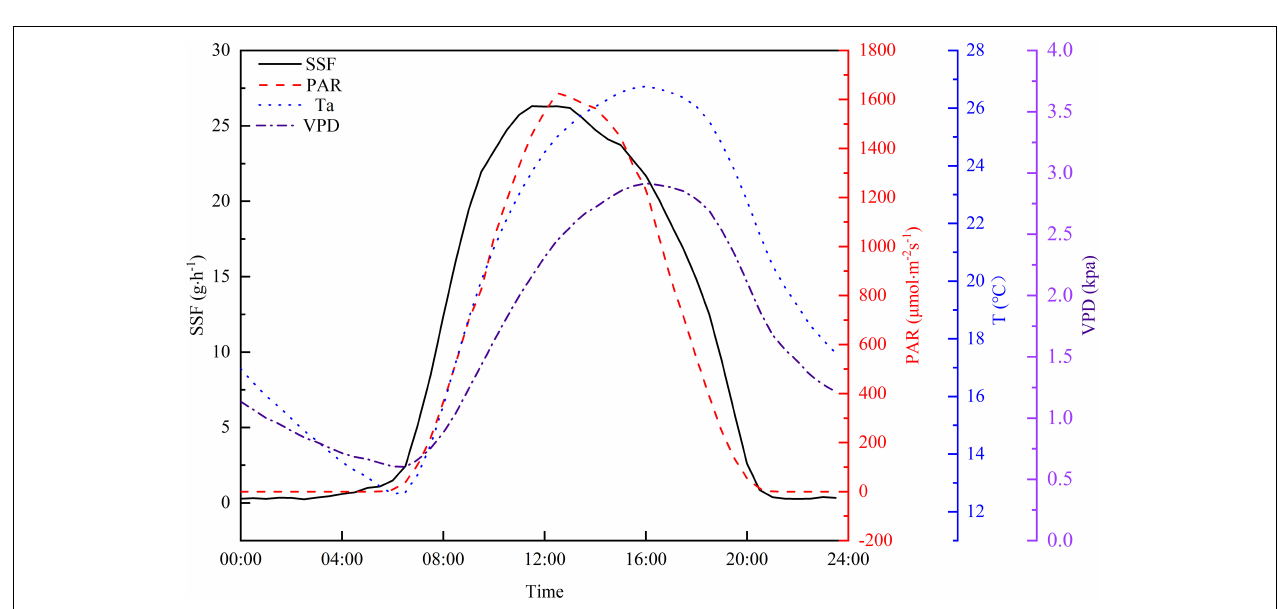
FIGURE 5 | Average diurnal cycle for half-hourly averaged SSF, PAR, Ta, and VPD during the growing season in 2020.